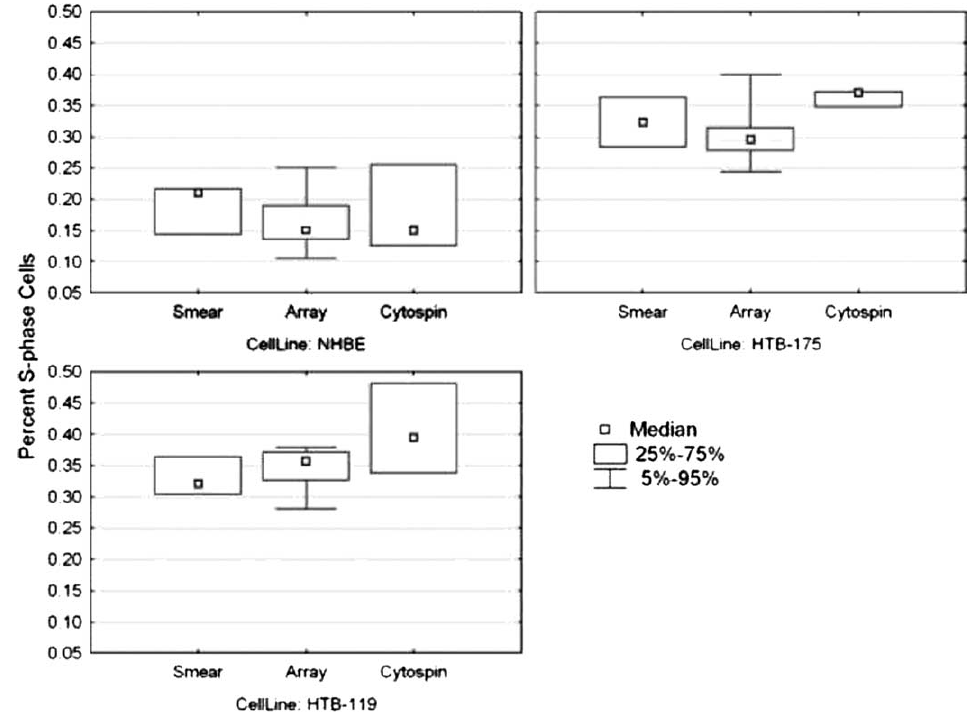
Fig. 8. Three different cell lines showing percentage of S-phase cells for three different preparation methods (smear, array and cytospin).